Question: What form of chart is displayed?
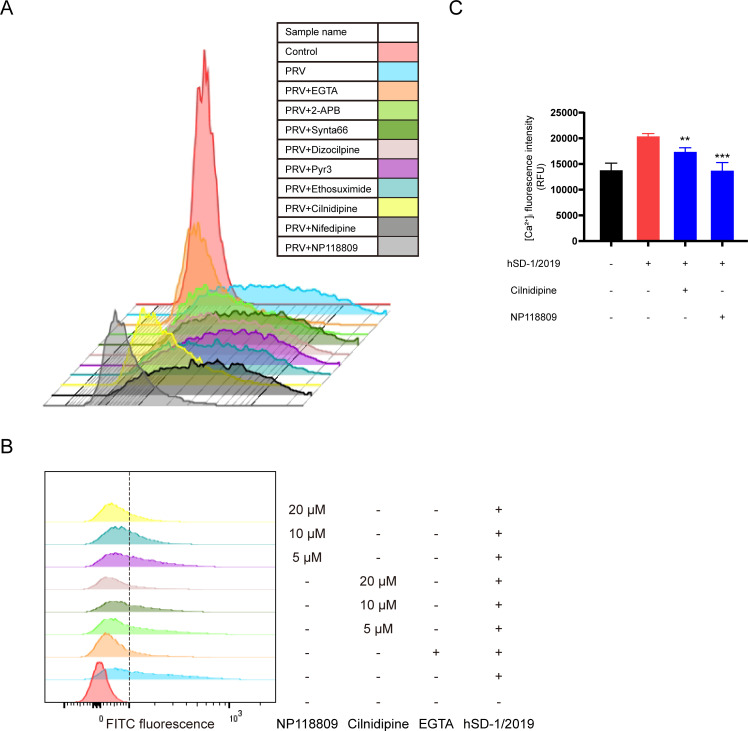
Answer: histogram